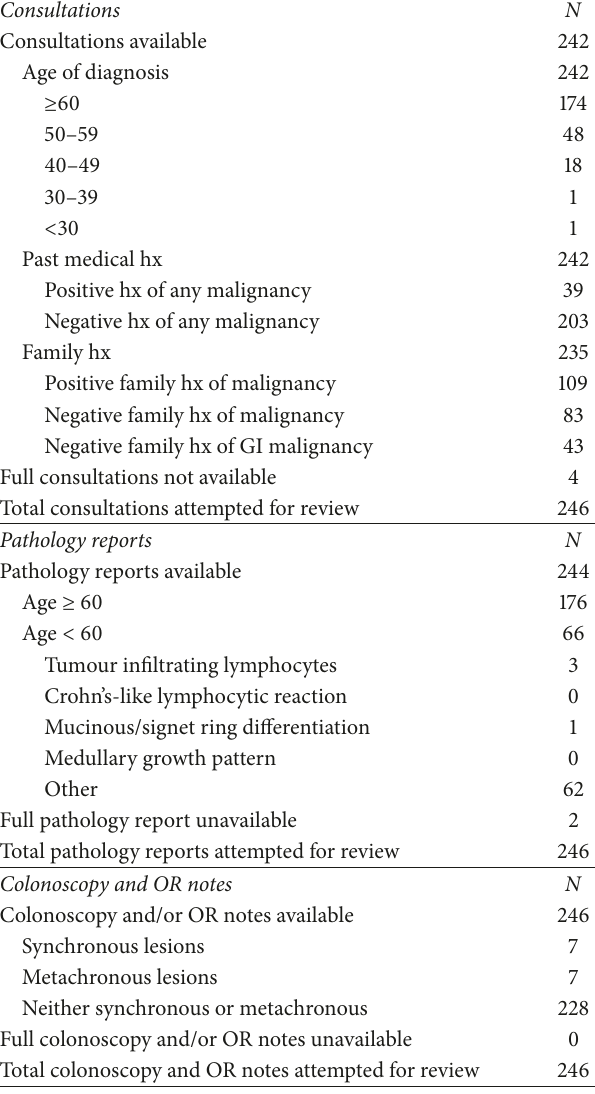
Table 2: Summary of data from chart